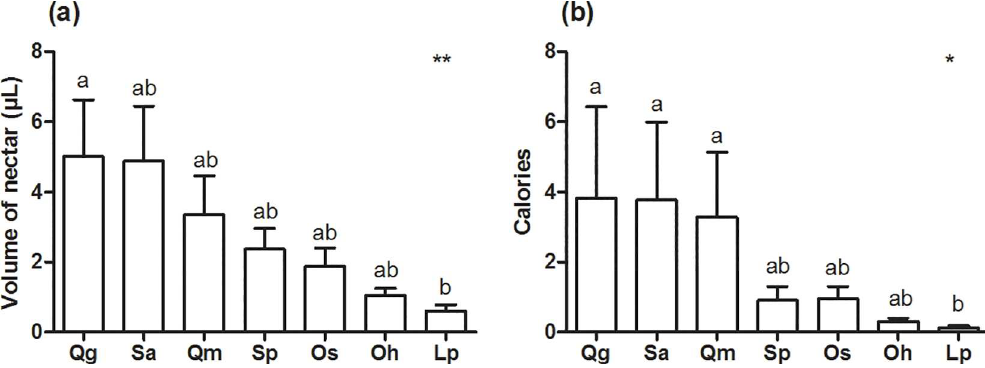
Fig 3. The total volume of nectar (a) and quantity of calories (b) produced at the EFNs in the seven assessedplant species. ( Qg ) Qualea grandiflora , ( Sa ) Stryphnodendron adstringens , ( Qm ) Q . multiflora .( Sp ) S . polyphyllum , ( Os ) Ouratea spectabilis ,( Oh ) O . hexasperma , and ( Lp ) Lafoensiapacari . Data were collectedfrom September to November2010 in Uberlaˆndia, Minas Gerais State, Brazil. The bars represent the mean and the SE. One-way ANOVA F [6, 69] = 3.03; p < 0.001 for (a, ** ), and F[ 6, 63] = 4.33; p = 0.01 for (b, * ). The letters represent the difference among the three periodsaccordingto Tukey’s